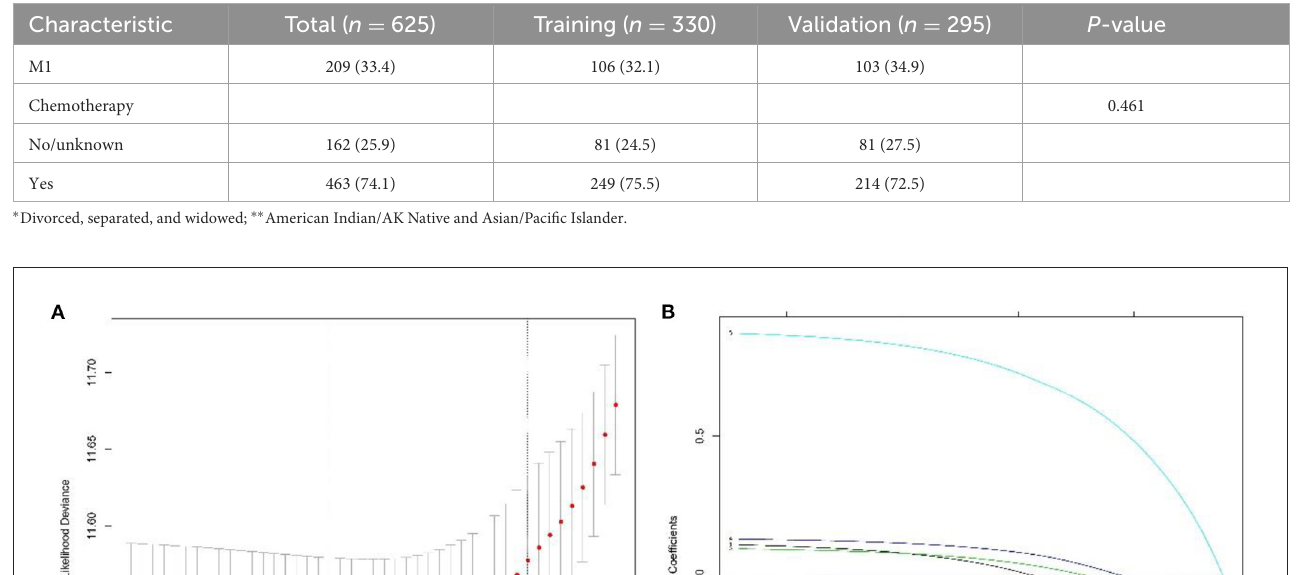
test. Continuous variables were compared by t -test or u -test.